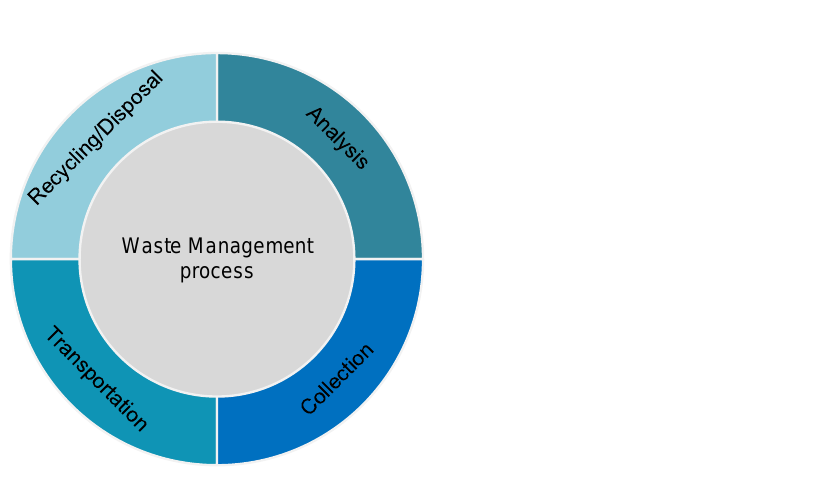
Figure 1. Process in solid waste management.